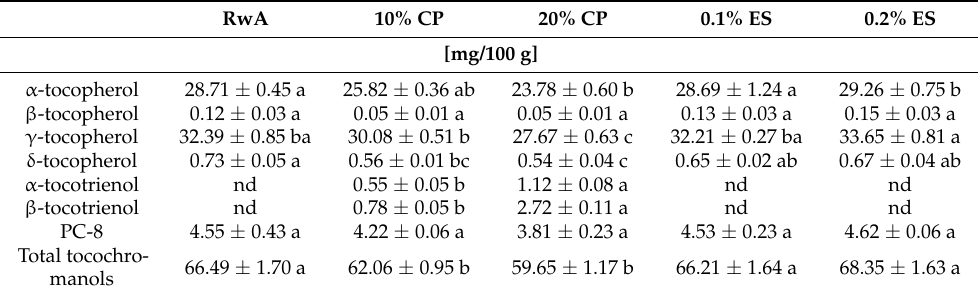
Table 3. The content of tocochromanols and their homologues in nonheated